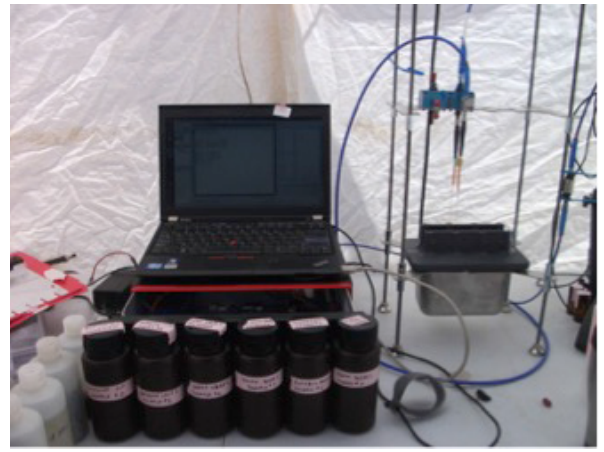
Figure 7: Prototype Optrode system (fibre optic-based ion-selective sensor). Deployed for a field test at Laguna Negra, a high-altitude lake near Santiago, Chile as part of the 2013 Planetary Lake Lander mission of the SETI Institute. This project demonstrated the techni-